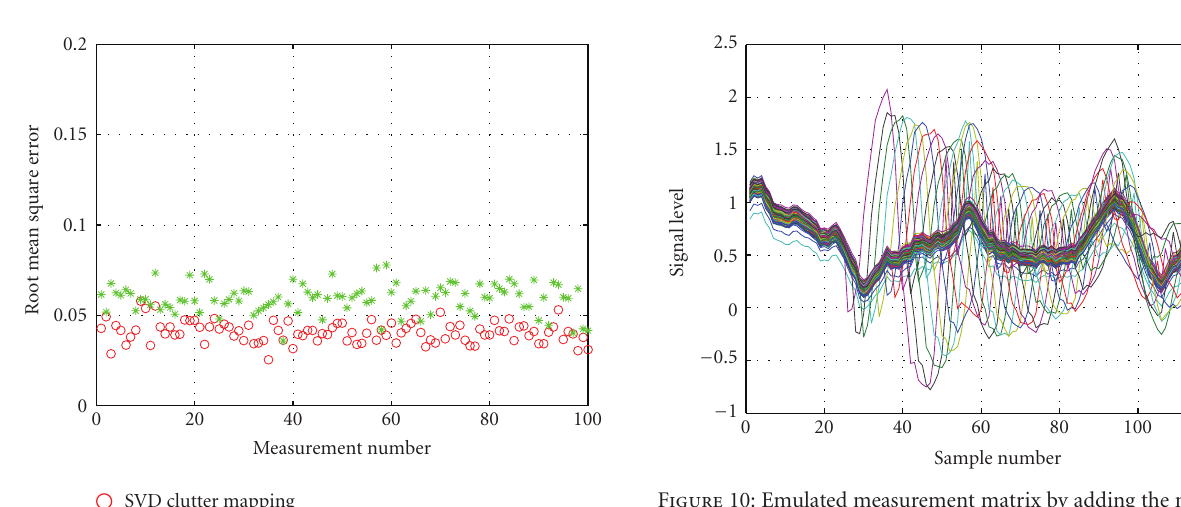
Figure 10: Emulated measurement matrix by adding the measure- ments of a moving target in anechoic chamber to the measurements of a clutter without moving targets.